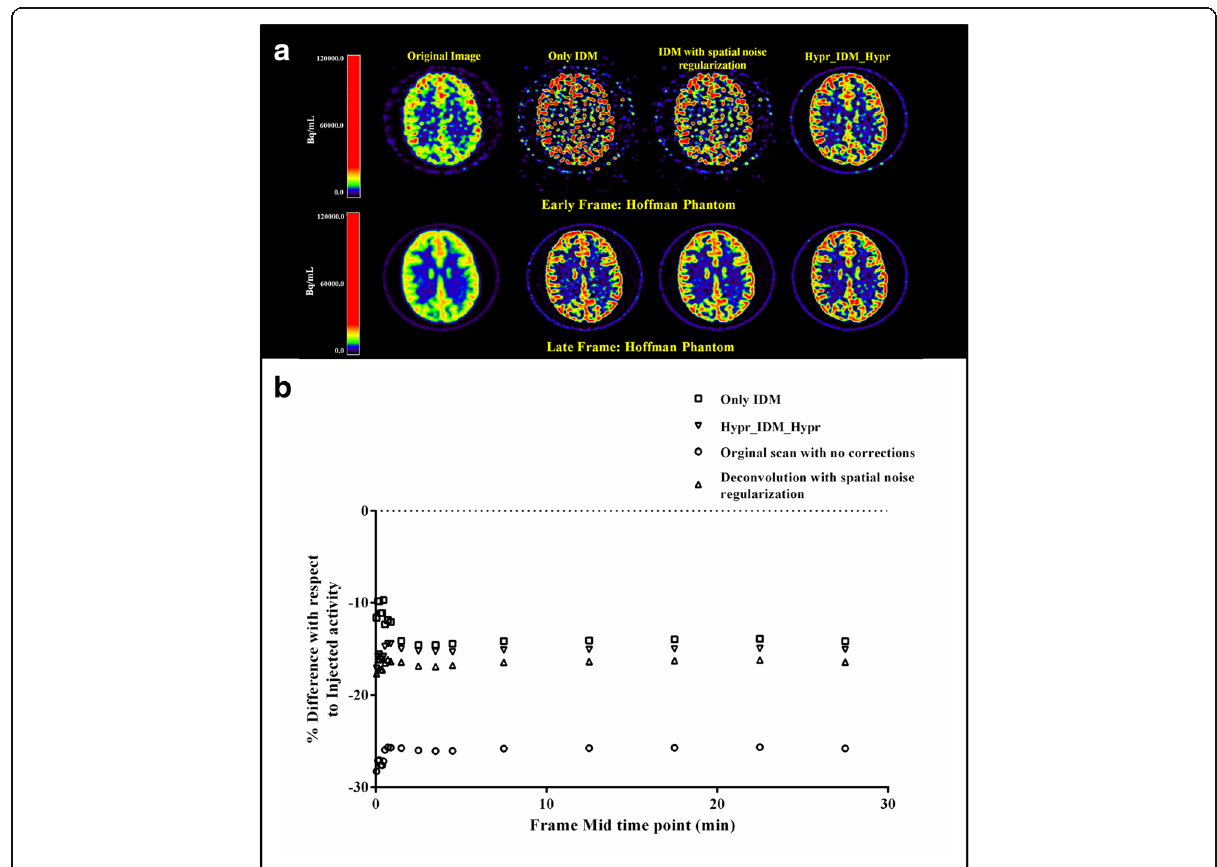
Fig. 4 a Hoffman phantom images before and after applying IDM with and without spatial smoothing or HYPR for both shorter and longer frame durations. b Associated bias in measured grey matter activity